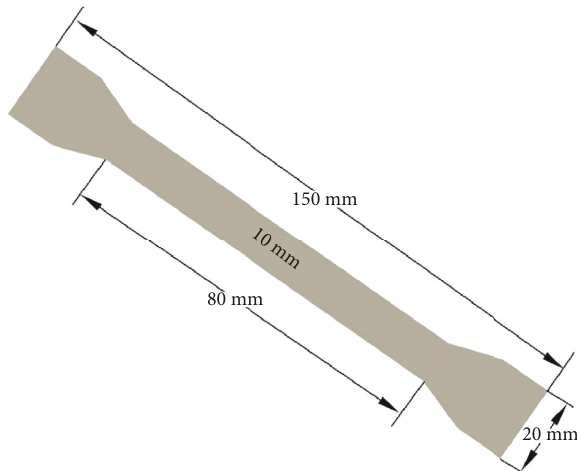
Figure 2: Specimen for tensile